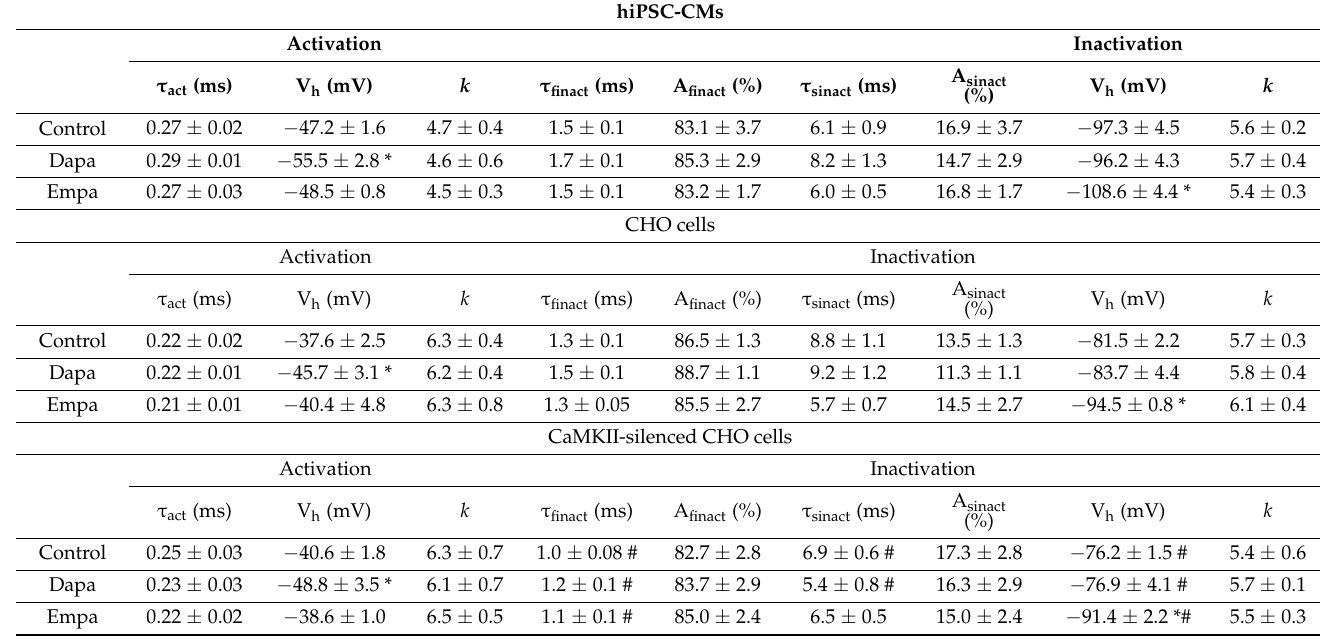
Table 1. Effects of dapa and empa on time and voltage dependence of peak I Na activation and inactivation. CHO = Chinese hamster ovary. hiPSC-CMs = human-induced pluripotent stem cell- derived cardiomyocytes. τ act = time constant of activation yielded from fit of a monoexponential function to peak maximum current. τ finact and τ sinact = fast and slow time constants of inactivation yielded from fit of a biexponential function to peak maximum current decay. V hact and k act = midpoint and slope values of conductance-voltage curves; V hinact and k inact = midpoint and slope values of inactivation curves. Each value represents mean ± SEM of >6 cells/experiments from at least three different dishes in each group. * p < 0.05 vs. control. # p < 0.05 vs non-silenced CHO cells. ANOVA followed by Tukey’s